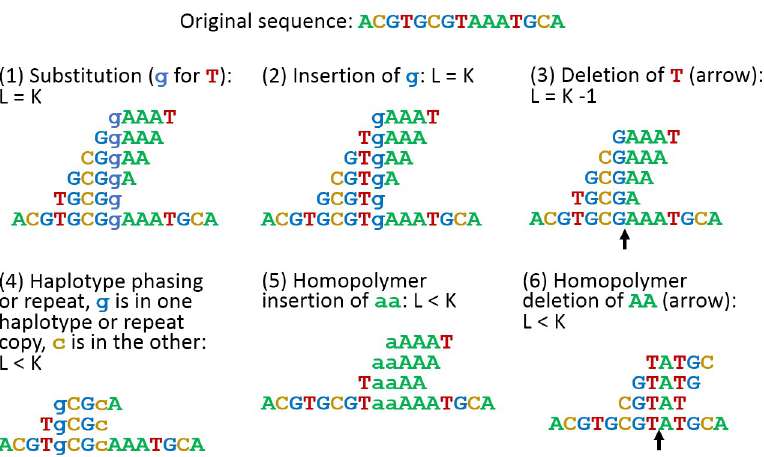
Fig 2. Illustration of the six most common error types that JASPER can detect and fix. Error bases are in lowercase. The error k-mers (K = 5) are shown above the sequence. Black arrows indicate locations of deletions.